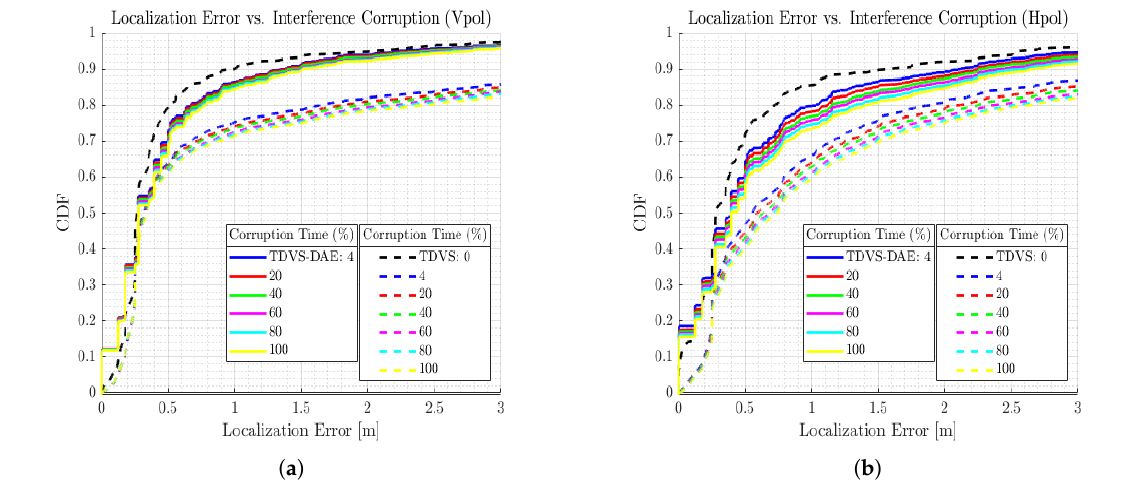
Figure 7. Localization performance of 3D CSI and 3D CSI with deep learning DAE for a single receiver located in Office #2 for ( a ) vertical transmitter polarization and ( b ) horizontal transmitter